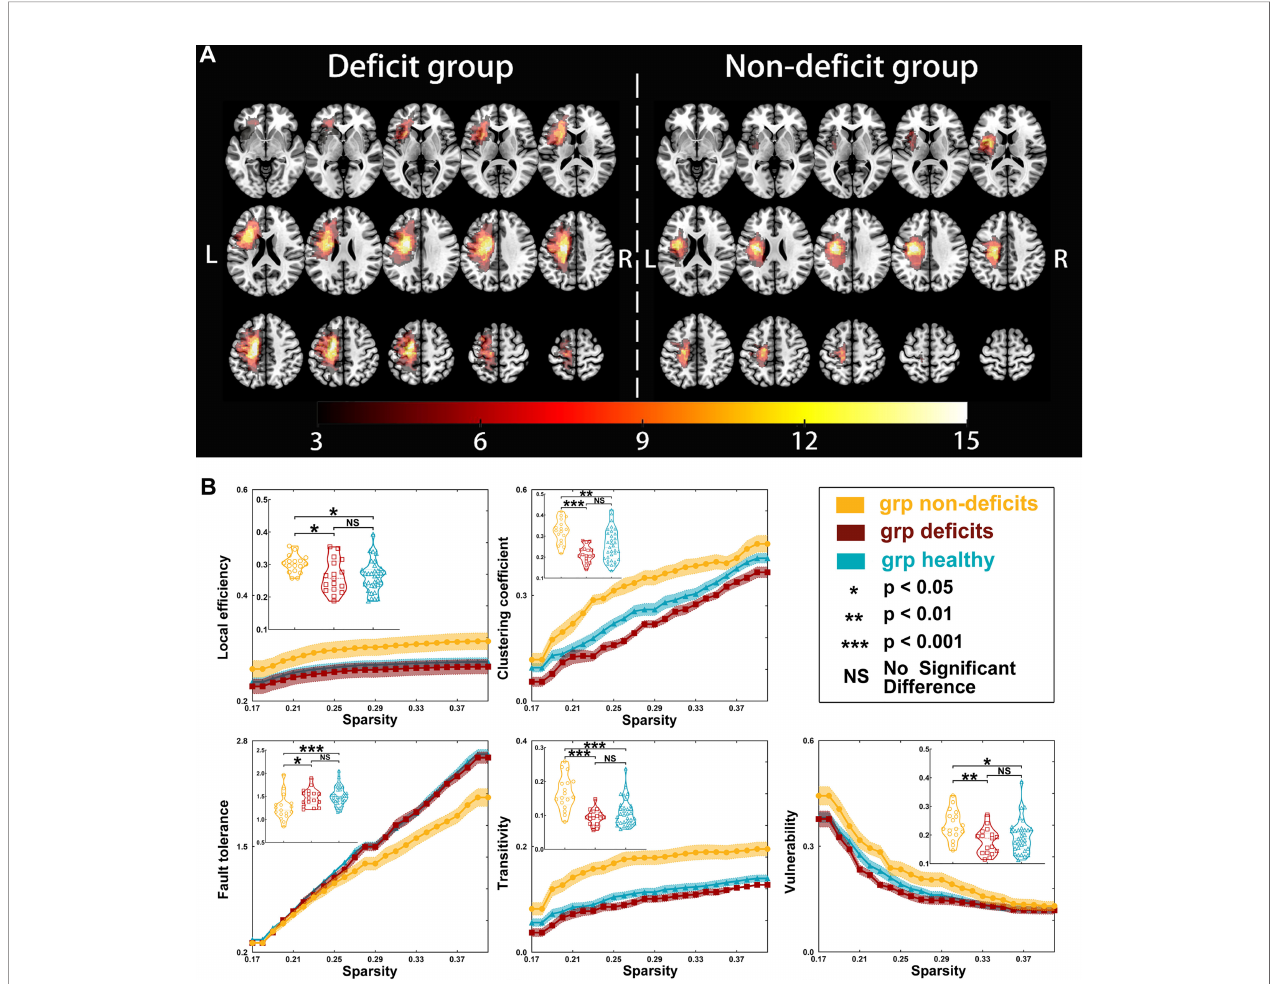
FIGURE 1 | Tumor location and global properties of patients with left hemispheric gliomas. (A) Overlapping results of gliomas in the left hemisphere. The value of the color bar represents the number of patients with tumors located in a same region. (B) Differences in global topological properties of the sensorimotor network in the contralesional hemisphere among the three